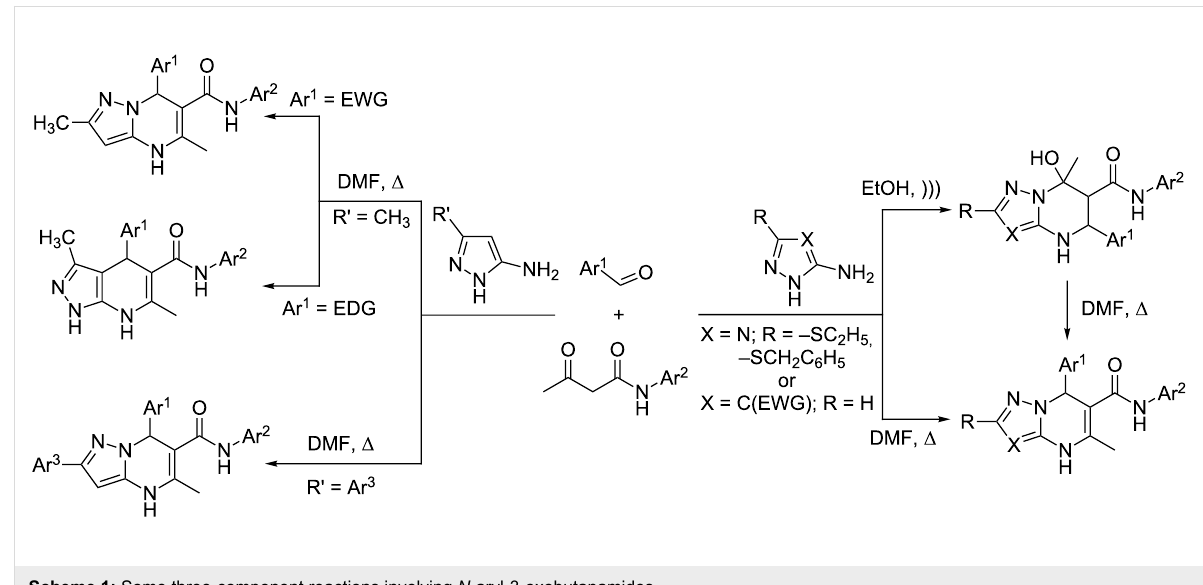
Scheme 1: Some three-component reactions involving N